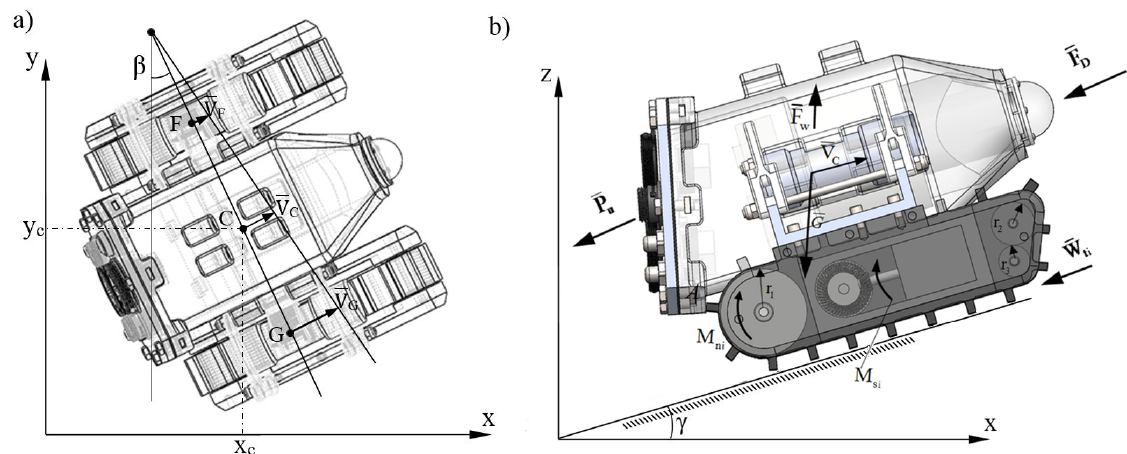
Figure 3: Robot frame rotated by the angle β (a) and dynamic model of the robot – forces (b).